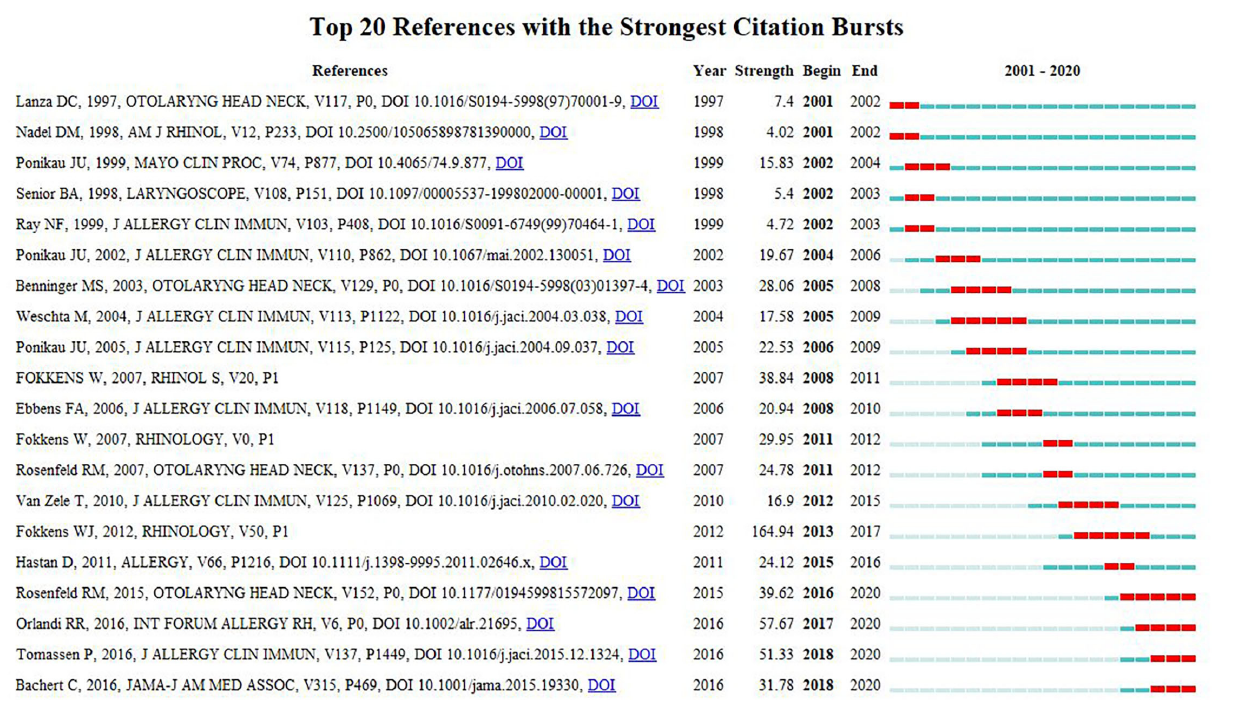
FIGURE 8 | Top 20 references with the strongest citation bursts.